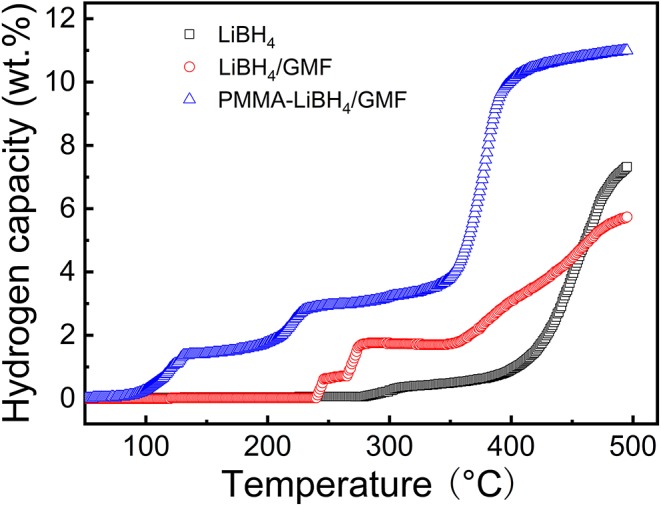
Temperature programmed dehydrogenation (TPD) curves of pure LiBH4, LiBH4/GMF, and PMMA-LiBH4/GMF.